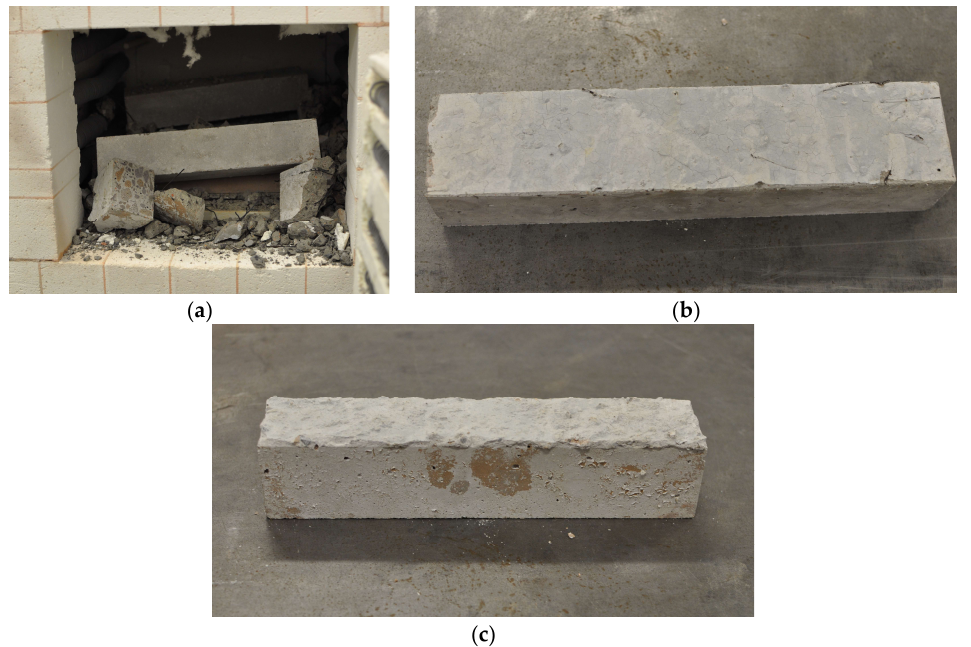
Figure 5. Failure of flexure specimens due to high temperature. ( a ) Spalling of CS-1.5 at 650 °C, ( b ) cracking of CS-0.5 at 900 °C, and ( c ) cracking of CPP at 1000 °C. Materials 2019 , x FOR PEER REVIEW